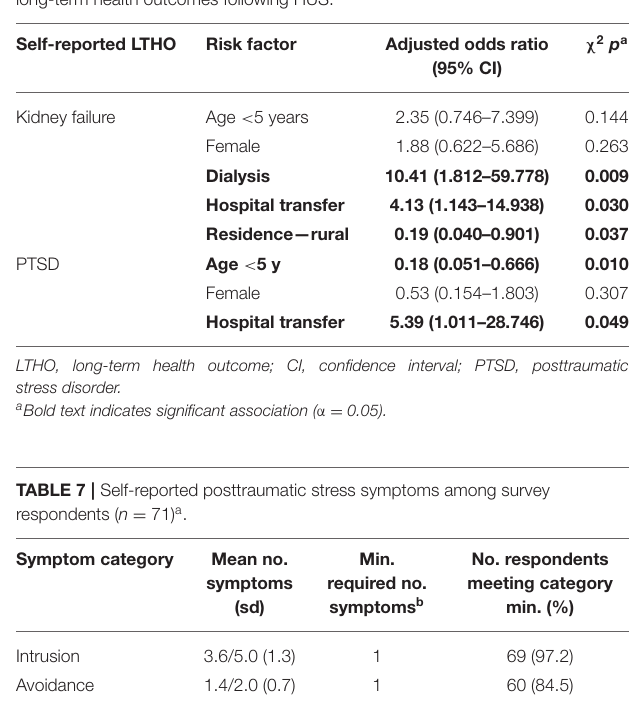
TABLE 6 | Multivariable logistic regression associations between risk factors and long-term health outcomes following HUS. Self-reported LTHO